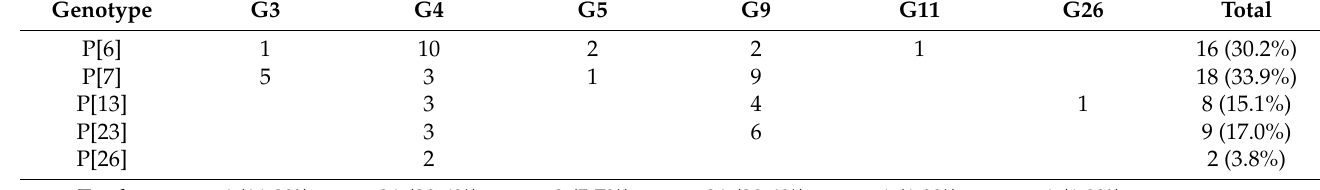
Table 1. G and P genotyping data for 53 Korean PoRVA-positive samples obtained between 2014 and 2018.